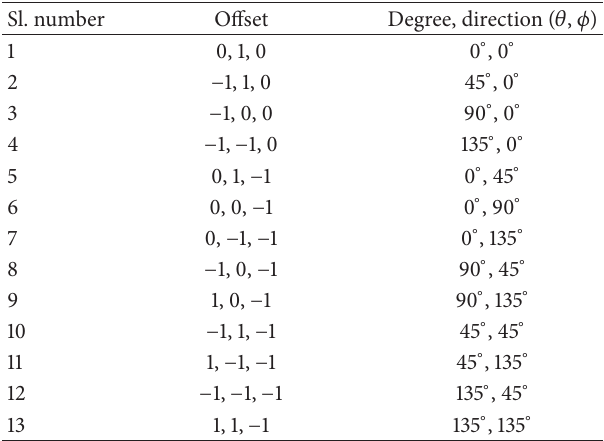
Table 1: Thirteen directions and offset for 3D images. Sl.